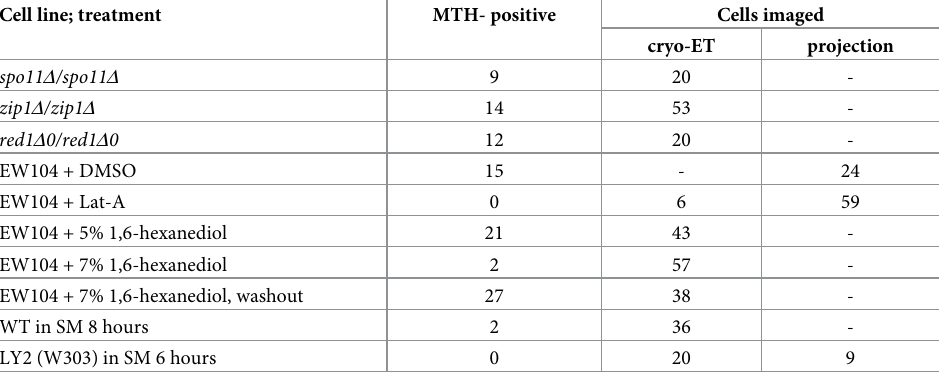
Table 1. Pachytene yeast structural cell biology. General cryo-ET observations Result Figure Ladder-like densities Not seen various Stacked-ladder densities in pachytene arrest Not seen various Ordered loops of nucleosome-like particles Not seen various 100-nm-wide nucleosome-free regions At MTH bundles various MTH general properties Presence after SM incubation 4–6 hours 2 Presence in late meiosis Absent/rare S1A Presence in haploid cells in SM Absent S1B Assembly timing relative to Zip1-GFP Coincident various Abundance during pachytene arrest Increase 3, S2 Sensitivity to 1,6-hexanediol Sensitive 4D Recovery after 1,6-hexanediol washout Re-polymerizes 4E Subunit organization Triple helical 5 Handedness Right 5D Oligomerization state Bundled various Packing density of MTH bundles Crystalline 6 Thickness of bundles � 100 nm various Presence in spo11 Δ cells Present S3A Presence in zip1 Δ cells Present S3B Presence in red1 Δ 0 cells Present S3C F-actin perturbation during pachytene Rhodamine-phalloidin location All cytoplasmic S5A Lifeact-mCherry foci location All cytoplasmic S5B, C